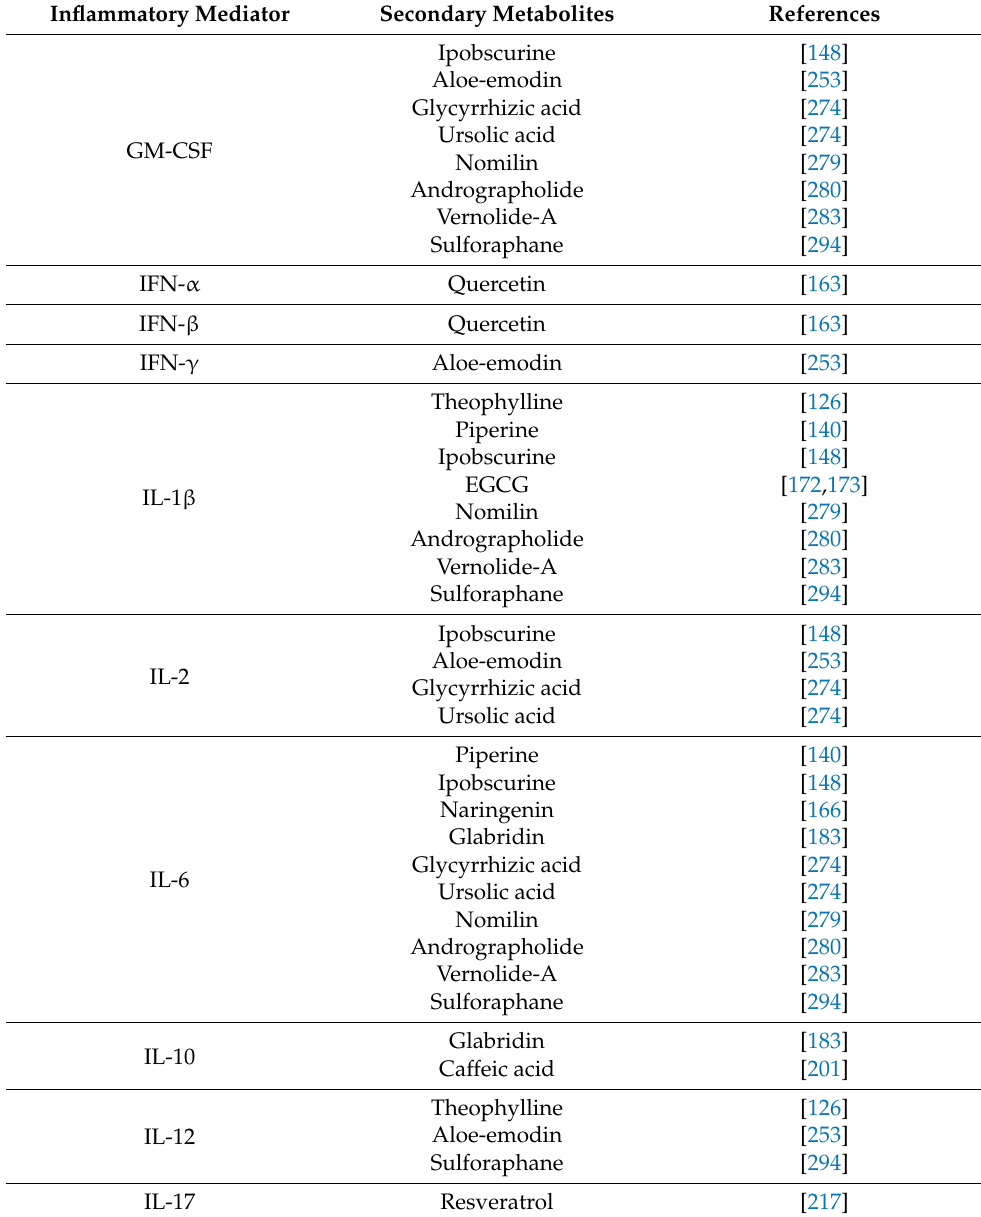
Table 2. Immunomodulatory effects of plant secondary metabolites on in vitro and in vivo melanoma